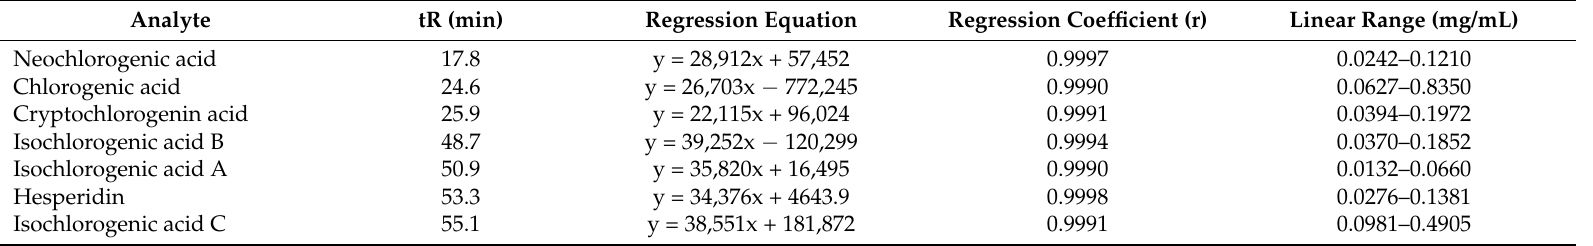
Table 2. Results of the analyses of linearity of calibration curves and sensitivities for the compounds in ZZX.